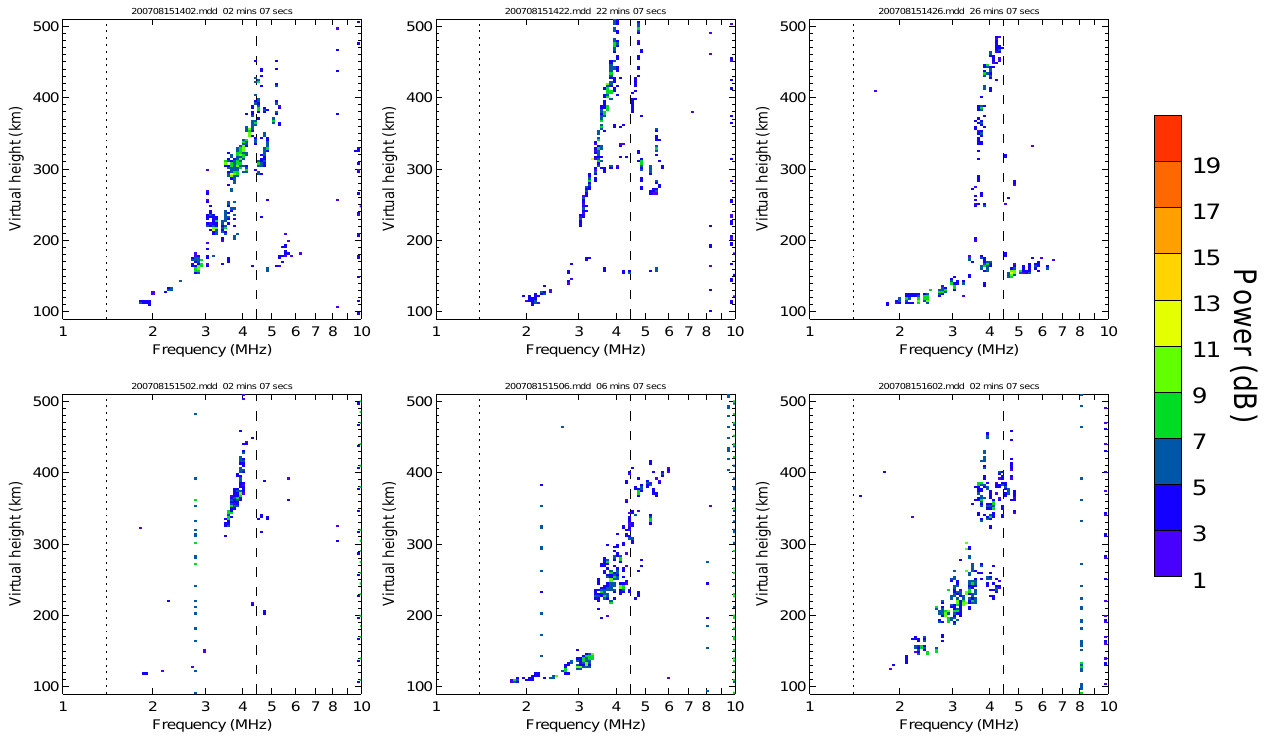
Fig. 3. Another series of ionograms beginning at 14:06UT and proceeding to 16:02UT on 15 August 2007 (interval 3). The features in these ionograms are consistent with an irregular ionosphere, which at least for a period during the interval is underdense. There is also evidence of an E-layer that interacts with radio waves having frequencies of about